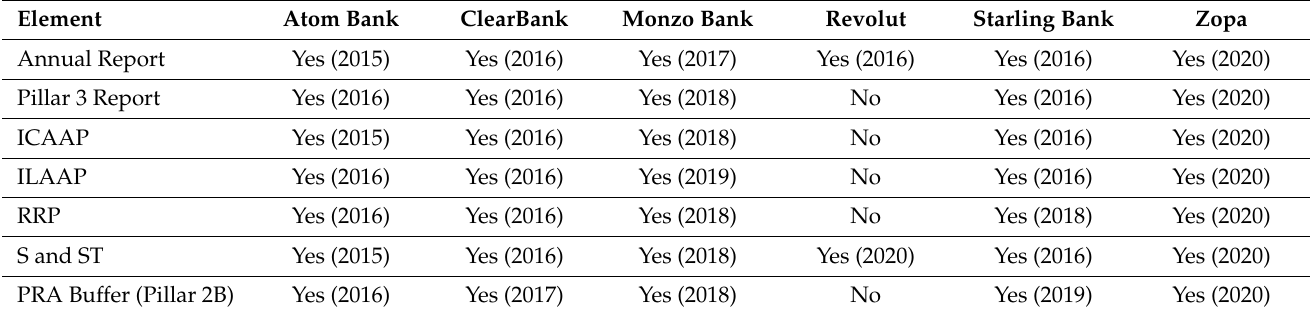
Table 3. Empirical Analysis—Fintech Disclosures.